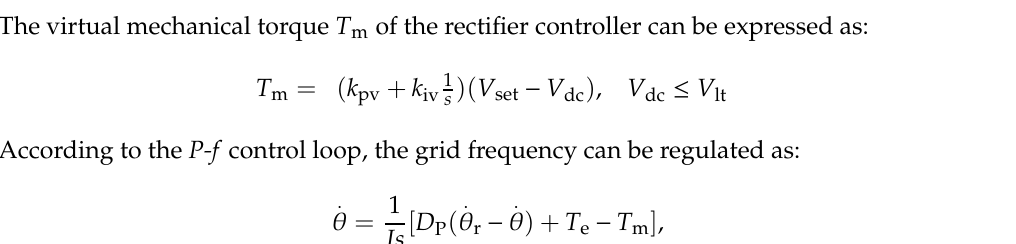
Figure 8. Rectifier control strategy of the master controller.